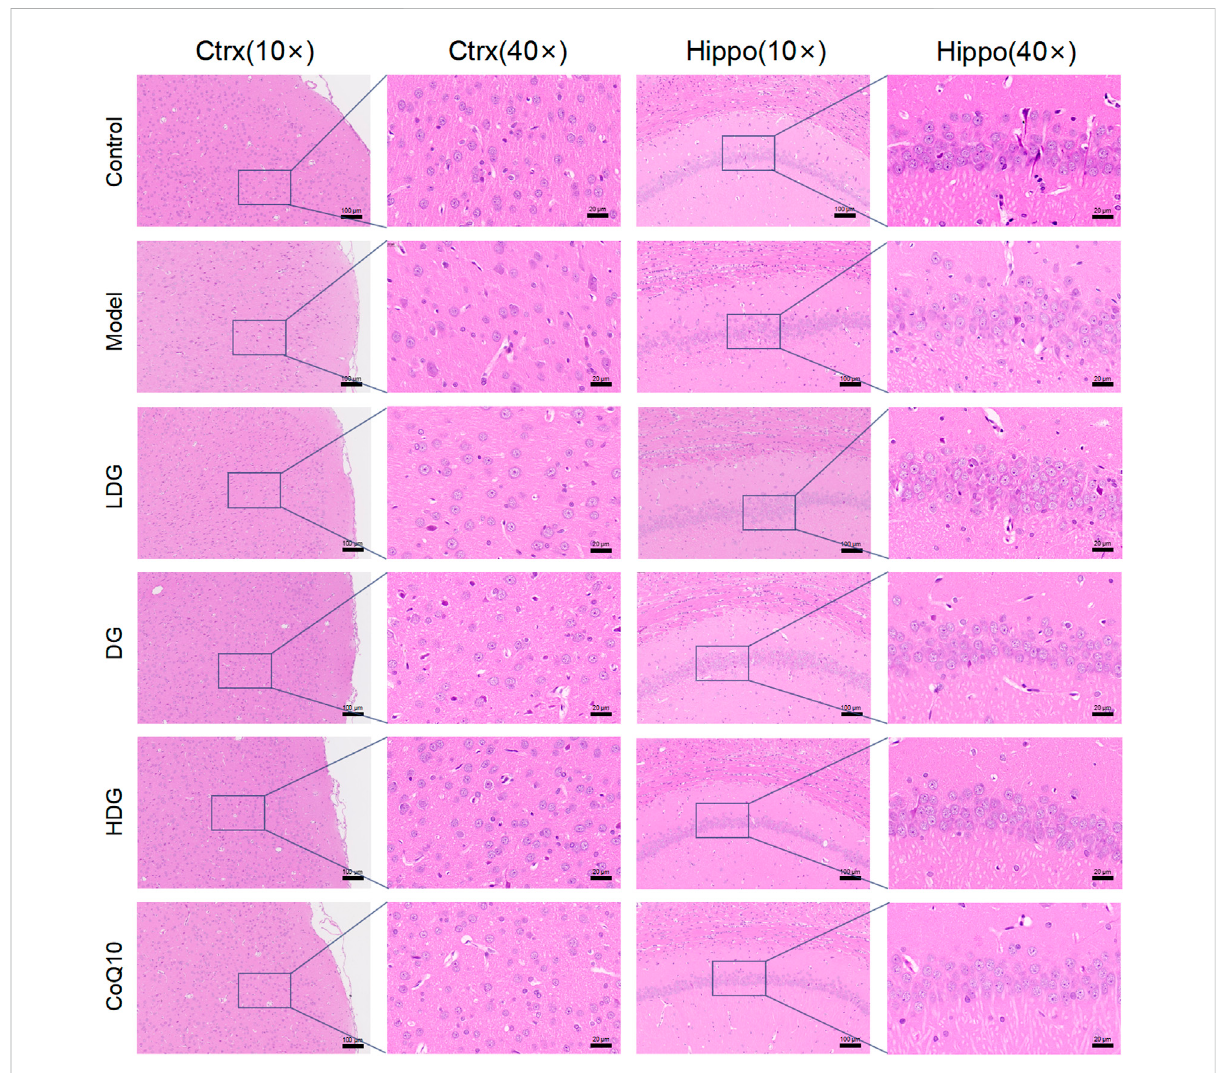
FIGURE 5 Histological changes associated with KPLD Treatment. H&E staining of the prefrontal cortex ( A : ×10, ×40 magni fi cation) and hippocampal CA1 region ( B : ×10, ×40 magni fi cation) of the rats were observed by light